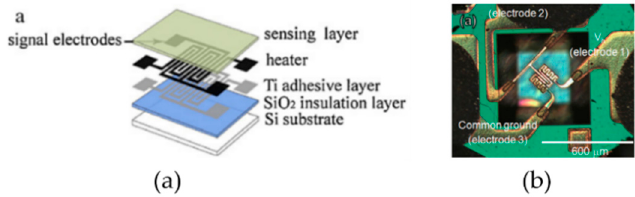
Figure 9. Coplanar geometry where heating and sensing electrodes lie on the same plane: ( a ) Au-loaded In 2 O 3 nanofiber gas sensor by Xu et al. (from [89]) and ( b ) SnO 2 nanowire gas sensor by Hwang et al. (from [90]).